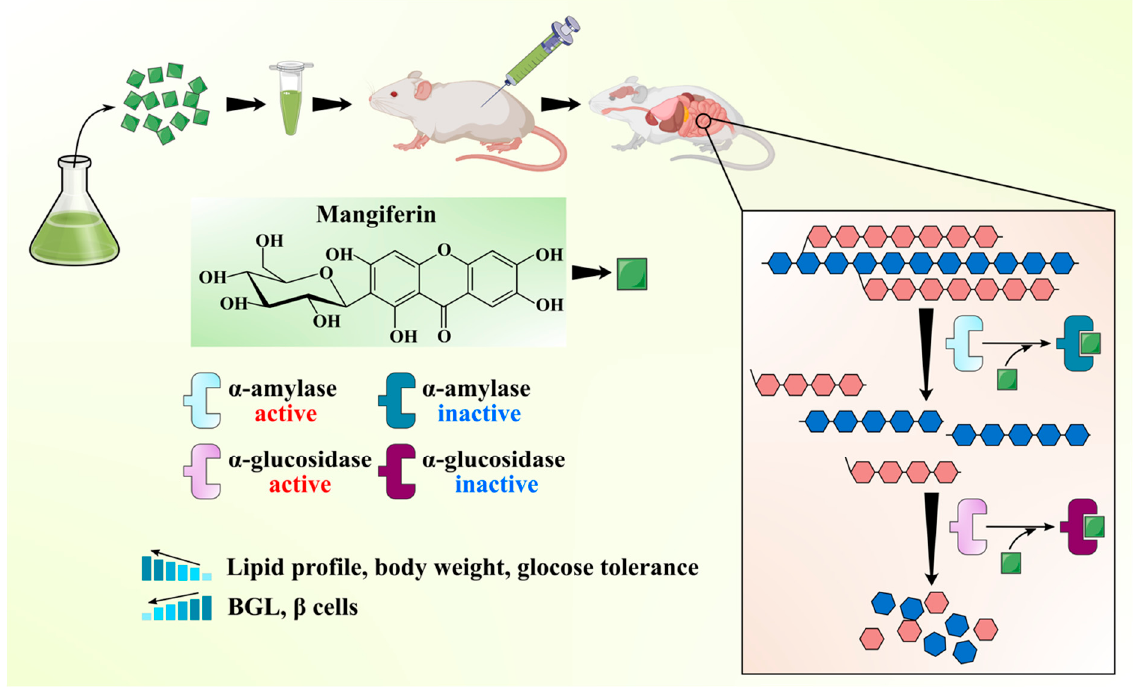
Figure 3. Schematic showing anti-diabetic activity of the mangiferin from mango leaves.